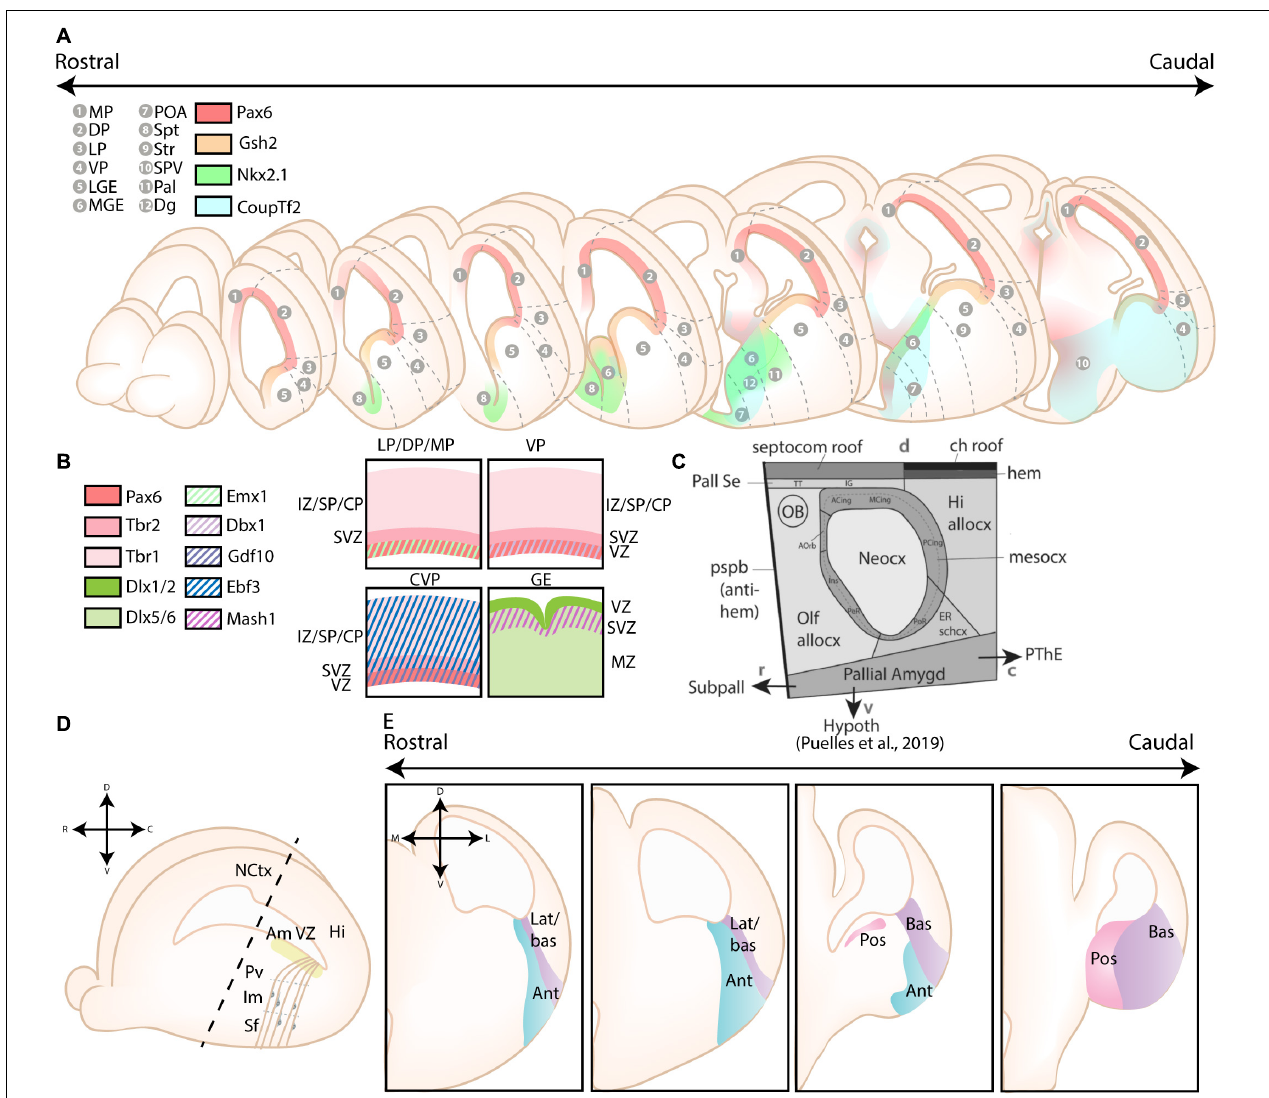
FIGURE 2 | Different models of the pallial cortex and amygdala. (A) Overview of common transcription factors and histogenetic regions of the developing murine brain. Transcription factors Pax6, Gsh2, and Nkx2.1 regulate broad telencephalic patterning, and cause the emergence of the pallial, striatal (Str), pallidal (Pal), and diagonal (Dg) sectors. Visible along the rostrocaudal axis are the four regions of the tetrapartite model [Lateral (LP), Ventral (VP), Medial (MP), and Dorsal Pallium (DP)]. Other depicted regions include the lateral, medial and caudal ganglionic eminences (LGE, MGE, CGE, resp.), the preoptic area (POA), the septum (Spt), and the supraopto-paraventricular hypothalamus (SPV). At intermediate and caudal levels, expression of CoupTf2 is shown. (B) Schemes depicting the expression of transcription factors in the ventricular zone (VZ), subventricular zone (SVZ) and mantle zone (MZ)/intermediate zone (IZ)/Subplate (SP)/Cortical plate (CP) of the LP/DP/MP, VP, caudoventral pallium (CVP) and ganglionic eminences (GE), highlighting their differences. (C) Figure adapted (greyscale) from Puelles et al. (2019), showing a tentative scheme of the concentric ring model of the pallium. (D) A side view of the developing murine brain, showing the lateral ventricle at the level of the ventral pallium and amygdalar pallium. Radial glial fibers arising from the ventricular zone of the pallial amygdala (Am VZ, yellow), located at the caudal pole of the telencephalon, course rostroventrally toward the pial surface. The pallial amygdalar nuclei can be divided along the radial axis in periventricular (Pv), intermediate (Im), and superficial (Sf) nuclei. (E) Radial view on the pallial amygdalar units along the rostrocaudal axis. The pallial amygdala is divided into a lateral (lat), basal (bas), anterior (ant), posterior (pos) and retroendopiriform (rep, not shown) radial unit. NCtx, NeoCortex; Hi, Hippocampus. Figure is based on images from Garcia-Calero et al. (2020) and Garcia-Calero and Puelles